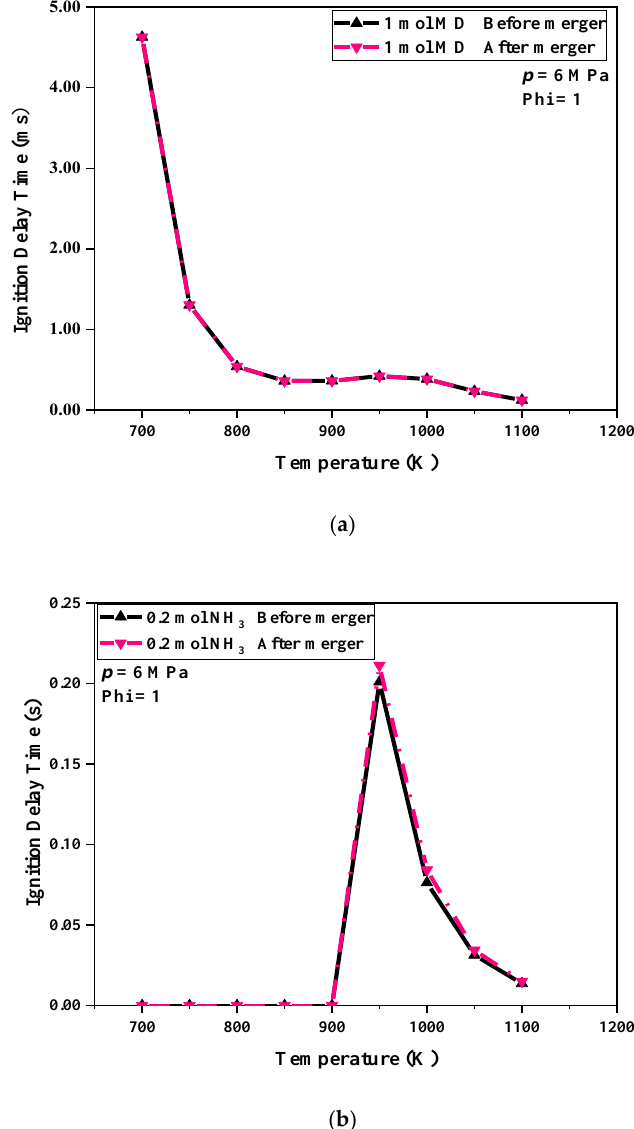
Figure 1. ( a ) Comparison of ignition delay times before and after MD mechanism merger. ( b ) Com-